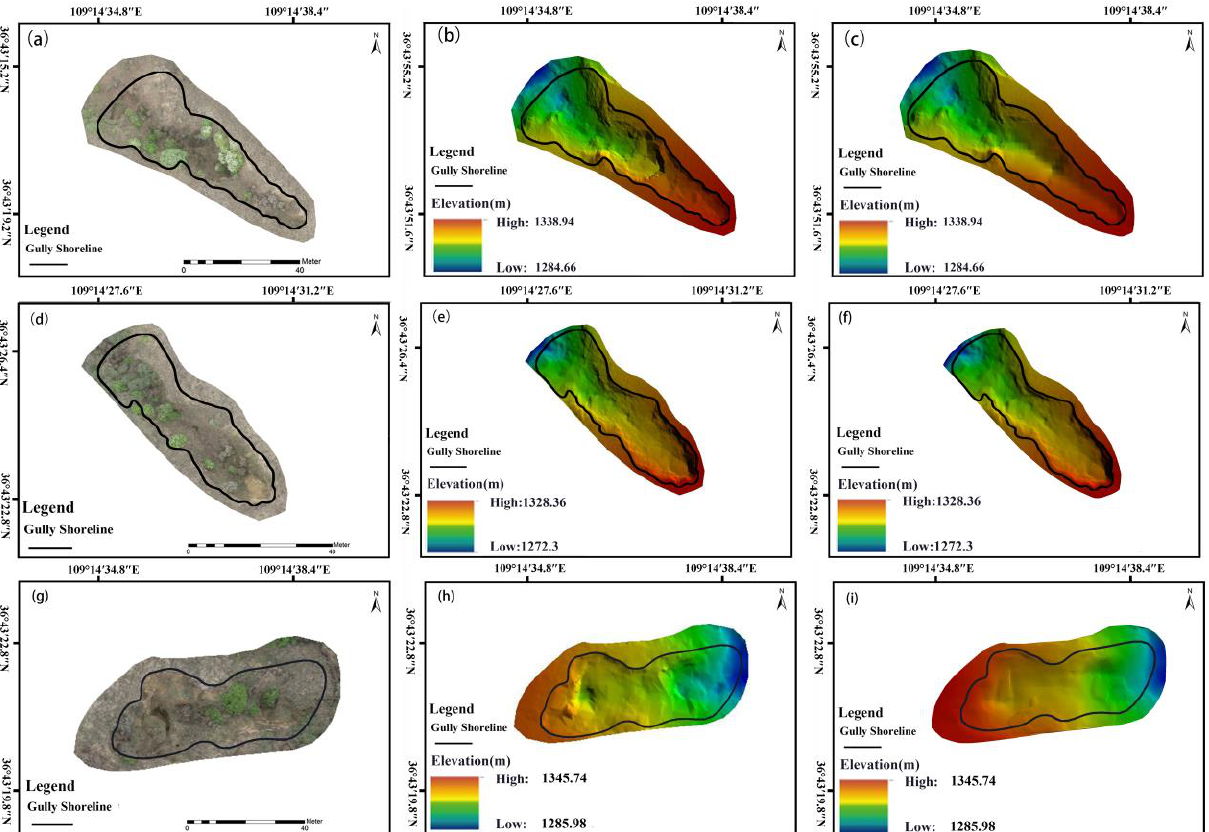
Figure 4. The DOM ( a ), UAV-derived DEM (b), and field inventory DEM ( c ) for a specific hillslope gully; DOM ( d ), UAV-derived DEM ( e ), and field inventory DEM ( f ) for a specific floor gully; and DOM ( g ), UAV-derived DEM ( h ), and field inventory DEM ( i ) for a specific bank gully in the study small watershed.